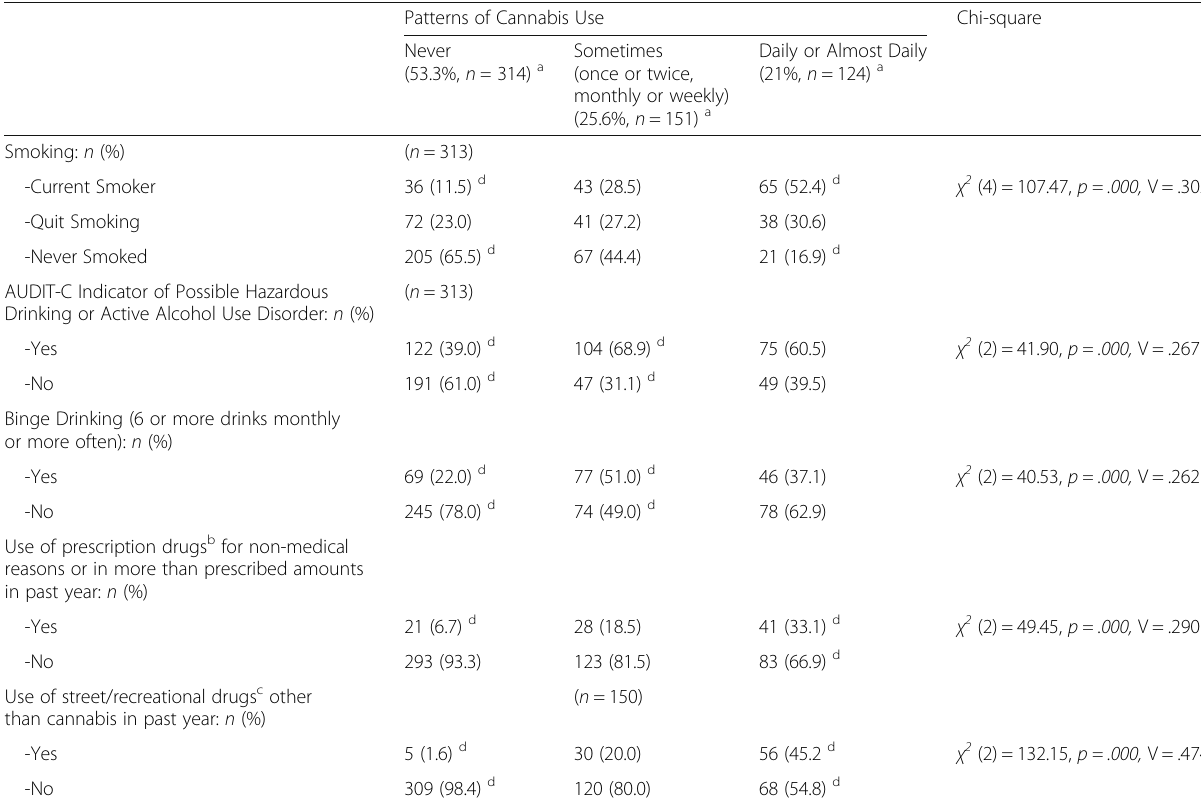
Table 7 Patterns of cannabis use in past year by substance use for the total sample ( N = 589)